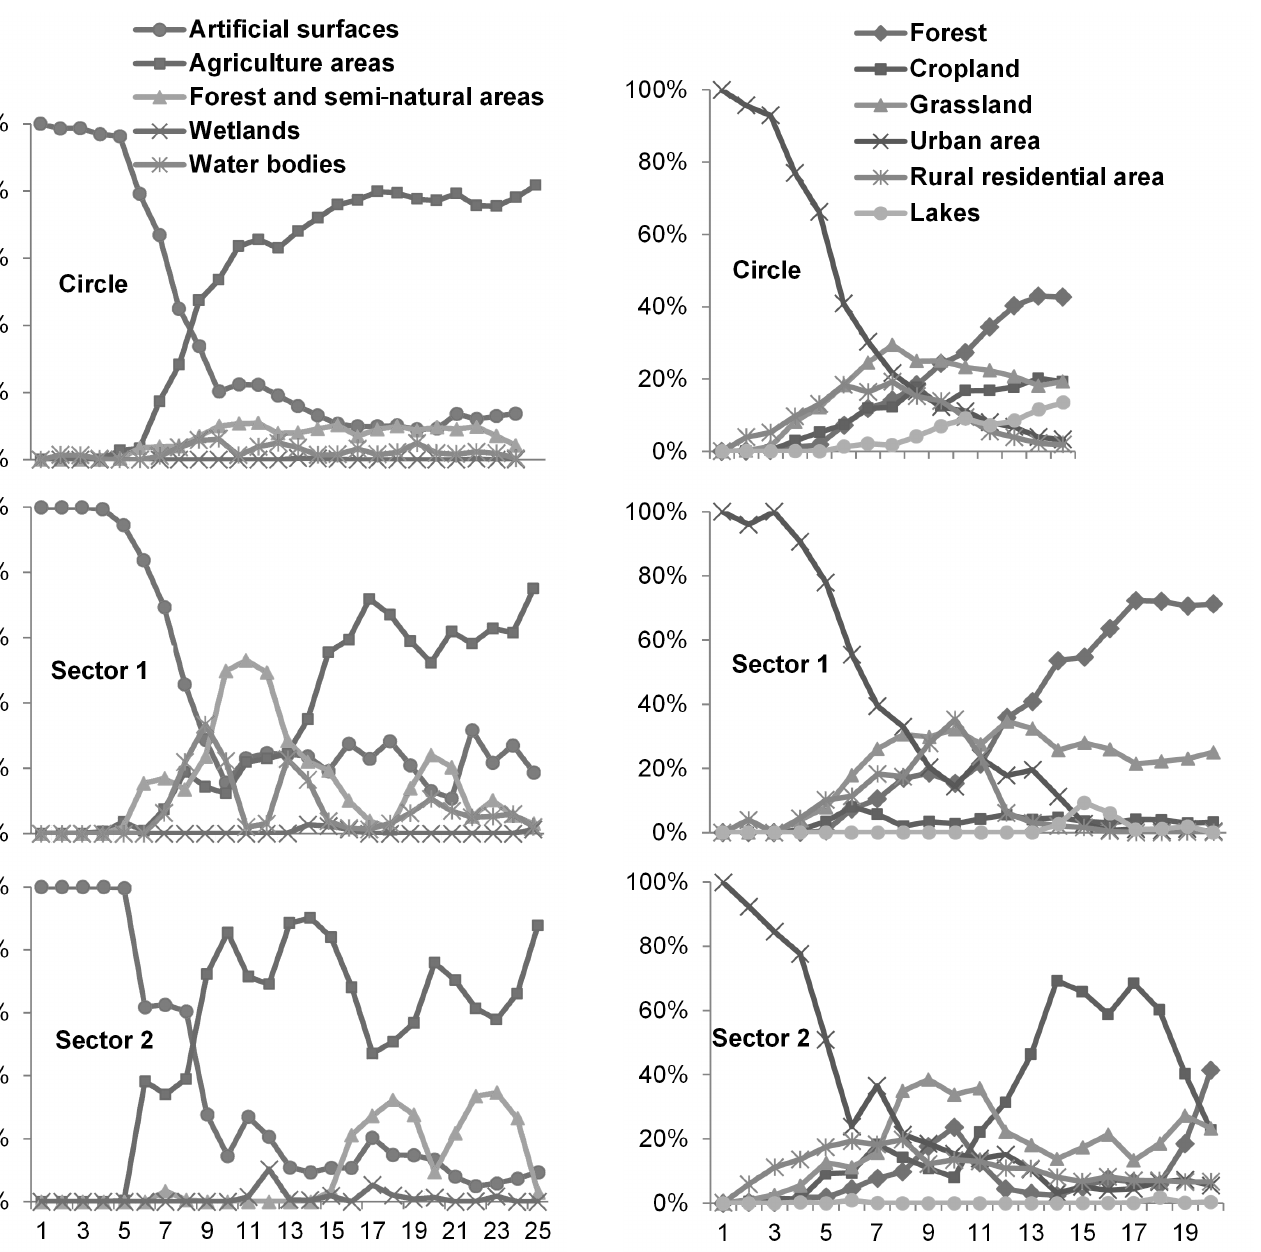
Figure 4: Land cover gradients along the Kunming urban- ringFigure 3: Land cover gradients along the Leipzig urban- rural area. The X-axis is the distance in kilometers from the rural area. The X-axis is the distance in kilometers city center of Kunming. The Y-axis is the area proportions from the city center of Leipzig. The Y-axis is the area of different land cover classes in the total area of the proportions of different land cover classes in the total associated concentric ring or concentric sector area of the associated concentric ring or concentric sector